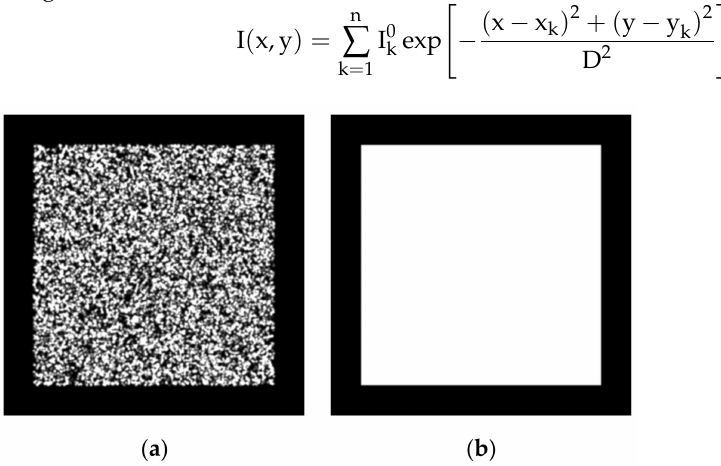
Figure 4. ( a ) Speckle pattern image; ( b ) Mask of speckle pattern